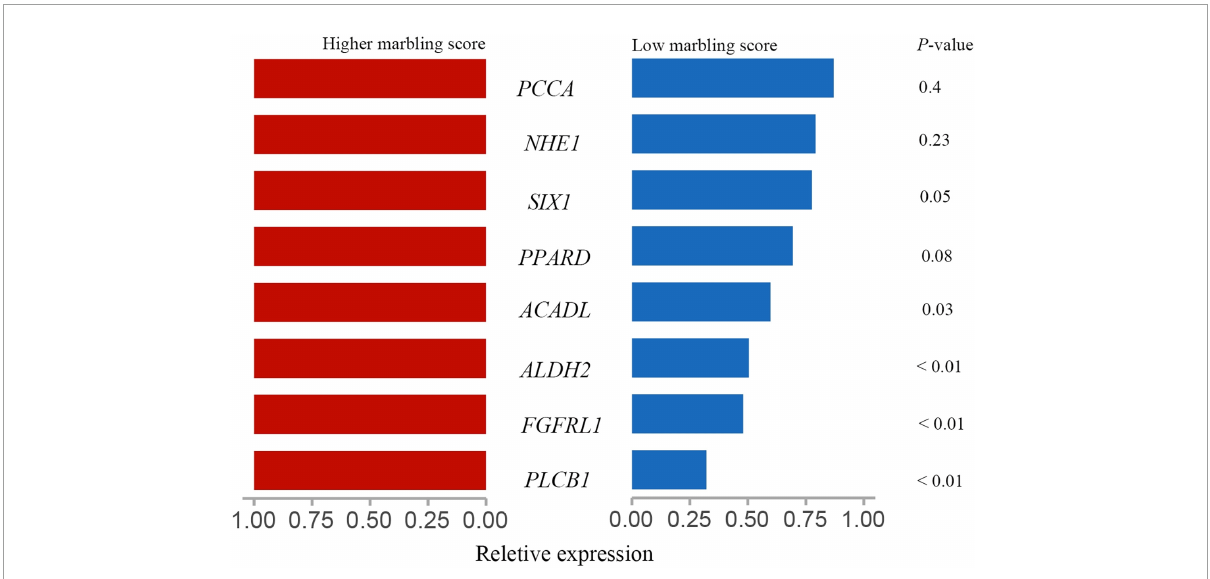
FIGURE6 Validation of the target genes in the rumen of Hu sheep. The red indicate the relative expression of target genes in rumen tissue of high marbling grade group; blue indicate the relative expression of target genes in rumen tissue of low marbling grade group. Statistical difference was declared at P < 0.05 ( T